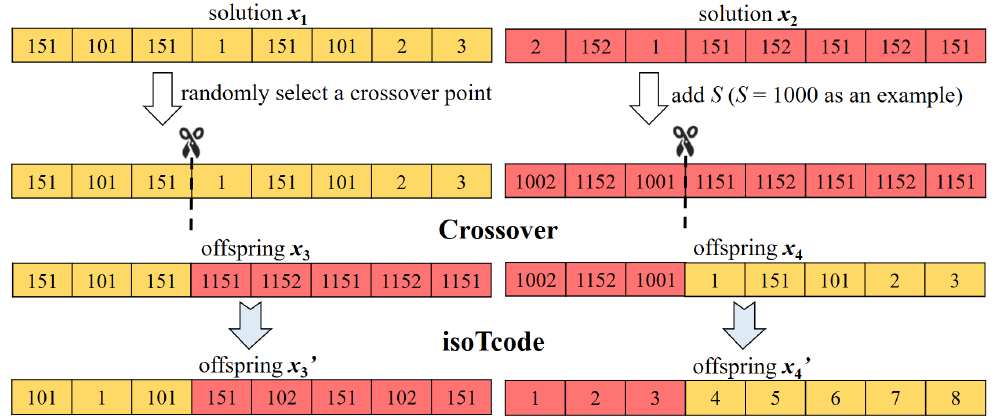
Figure 6. An example of the Crossover_isoT.